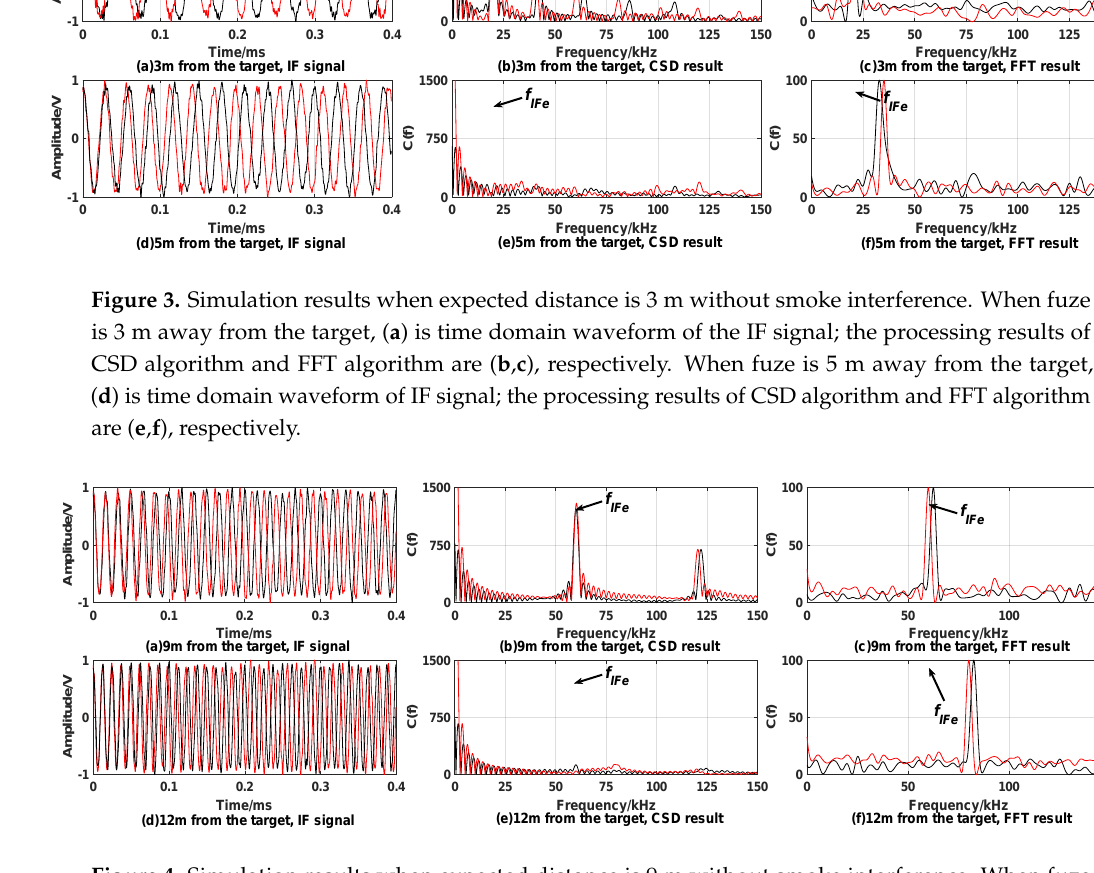
Figure 4. Simulation results when expected distance is 9 m without smoke interference. When fuze is 9 m away from the target, ( a ) is time domain waveform of IF signal; the processing result of CSD algorithm and FFT algorithm are ( b , c ), respectively. When fuze is 12 m away from the target, ( d ) is time domain waveform of IF signal; the processing result of CSD algorithm and FFT algorithm are ( e , f ), respectively.